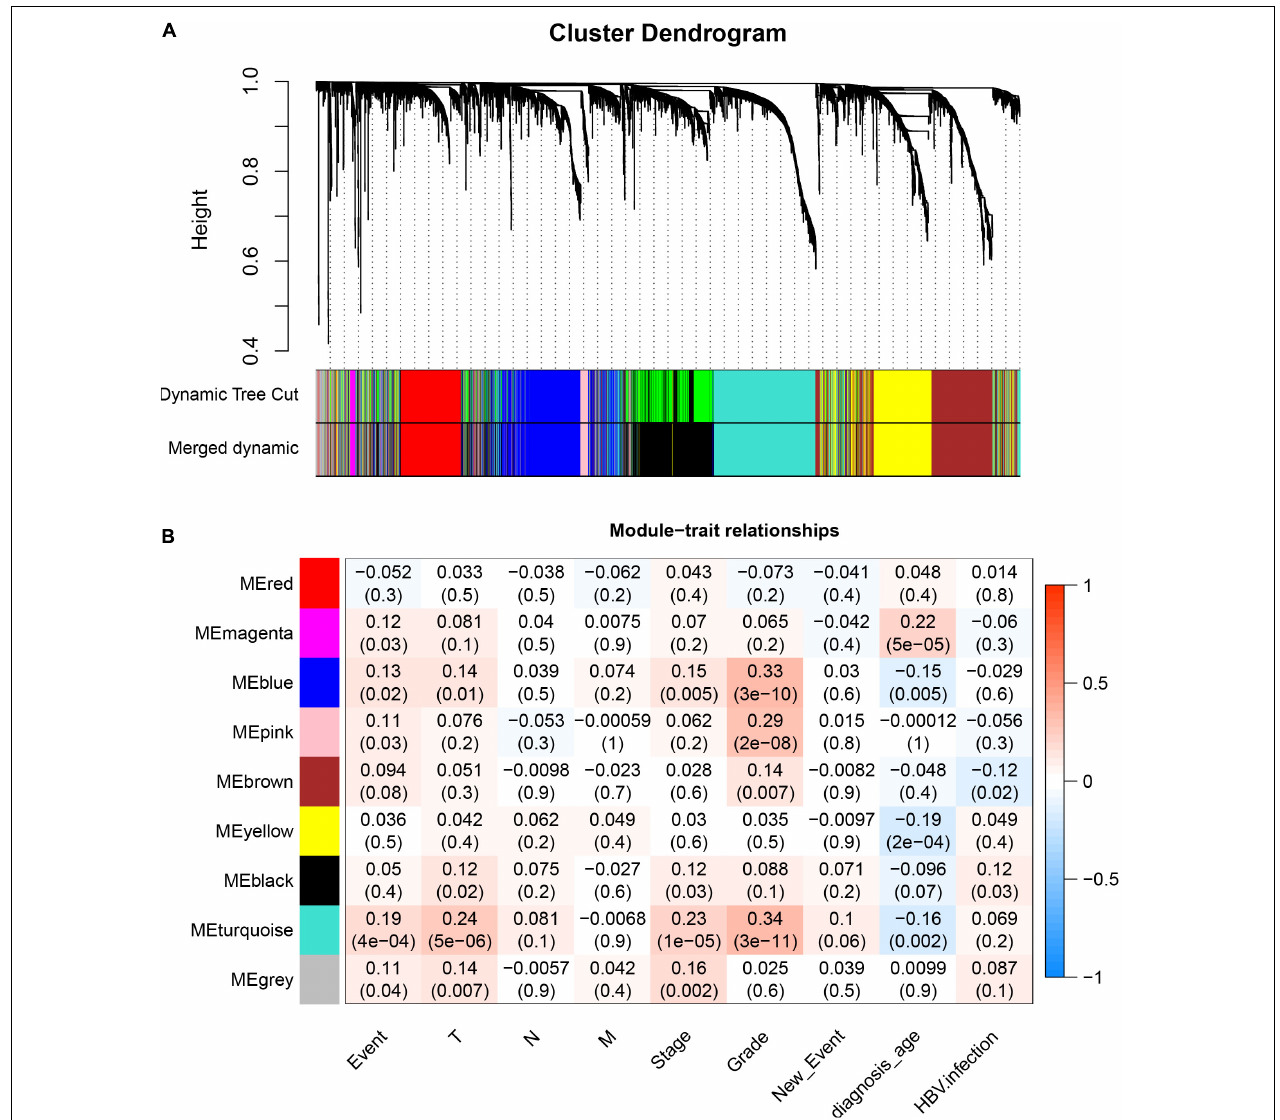
FIGURE 5 | Identification of modules associated with histologic grade of HCC. (A) Dendrogram of all differentially expressed genes clustered based on a dissimilarity measure (1–TOM). (B) Heatmap of correlation between module eigengenes and clinical information for HCC.